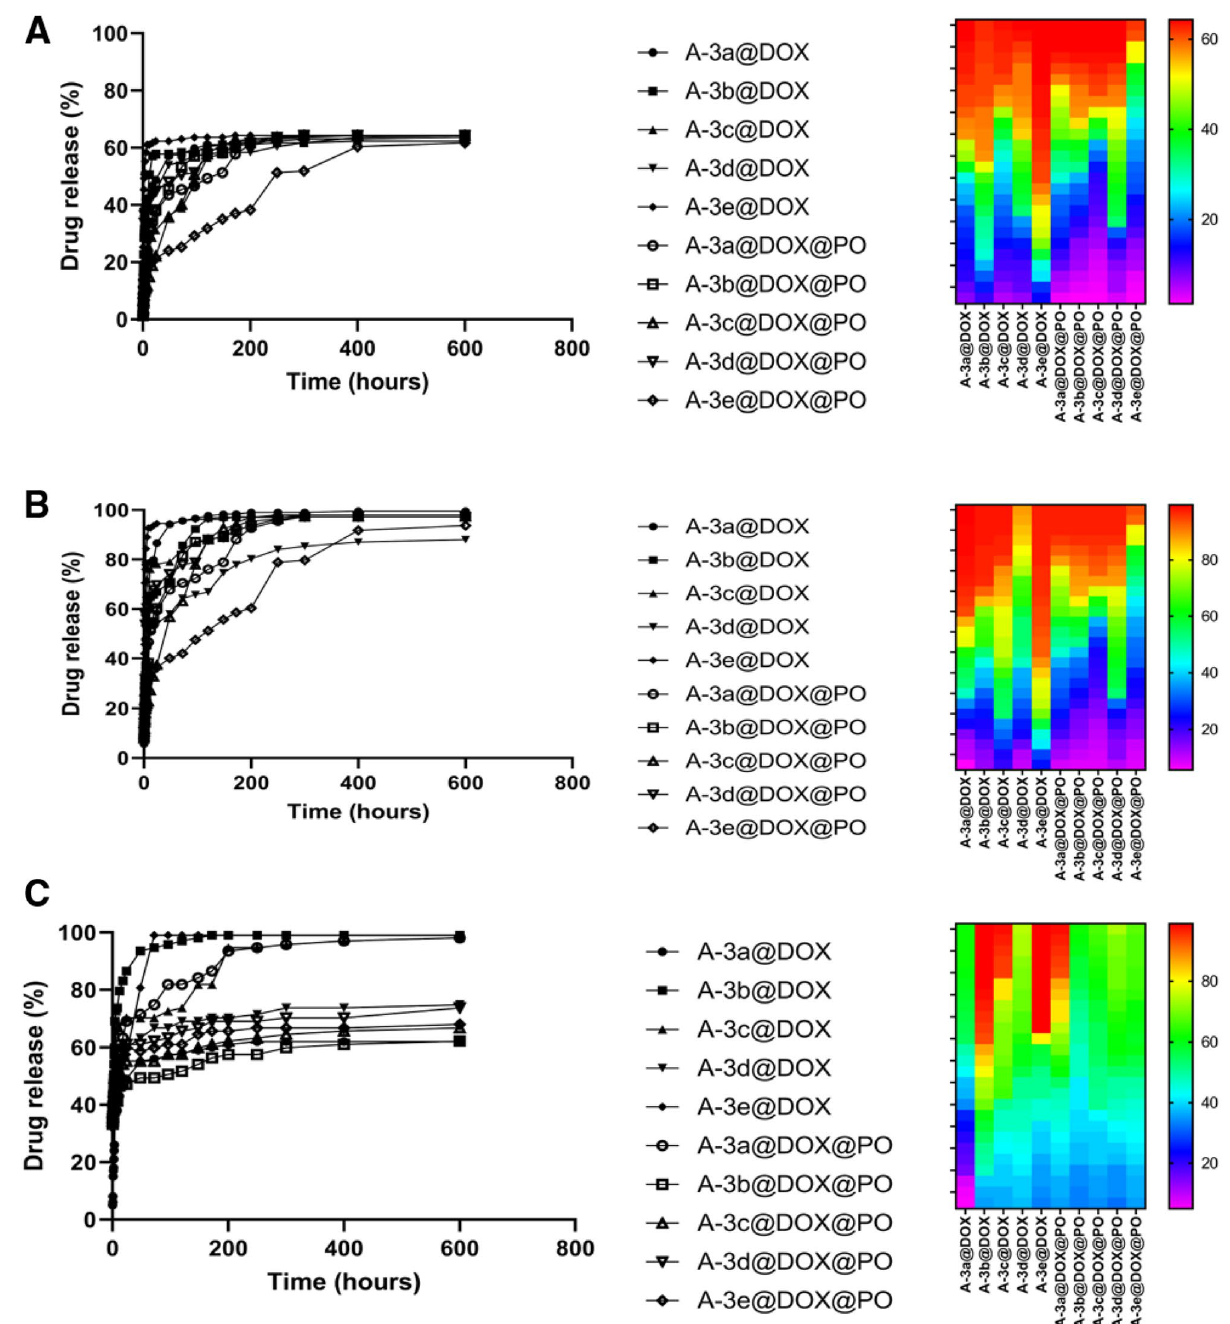
Figure 3. Drug release at pH 4.5 ( A ), pH 5.5 ( B ) and pH 7.2 ( C ). The modification of nanoparticles with PO promotes drug release capacity and they provided sustained release of DOX. The DOX release was steady after 250 h. Highest release occurred at pH 5.5 and lowest release was observed at pH